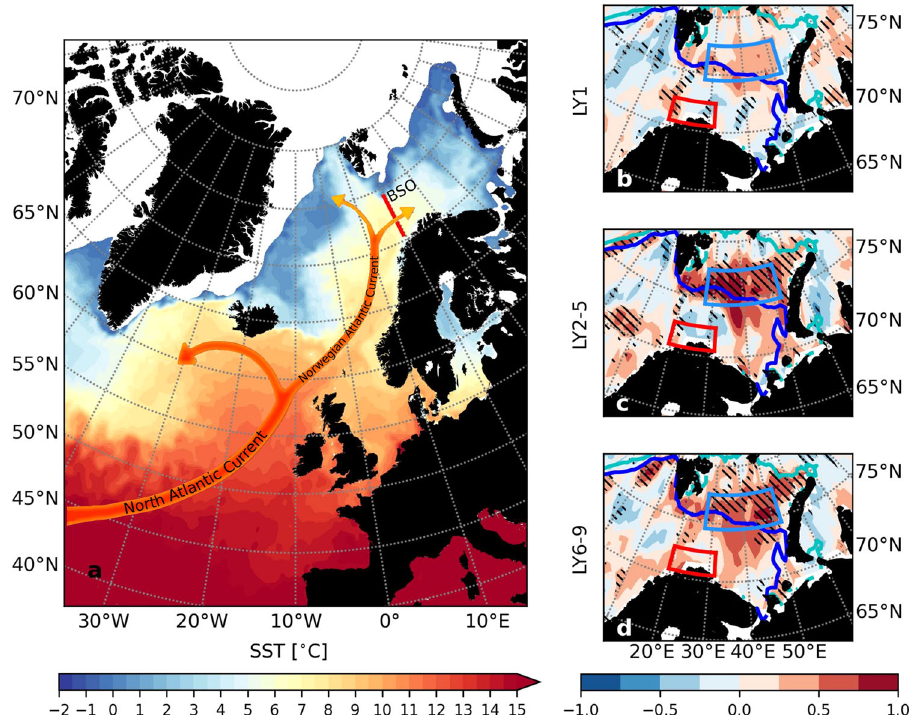
Fig. 1 Phytoplankton predictability. a Snapshot of SST in the Subpolar North Atlantic, and the Nordic and Barents seas from the OCCI dataset 67,68 , daily mean from April 15 2007. Areas with an ice cover exceeding 30% are marked in white. The pathways of the North Atlantic and Norwegian Atlantic currents are marked with arrows. The Barents Sea Opening is marked with a red line. b – d Anomaly correlation ( fi lled contours) between annual mean observed (satellite-derived) chlorophyll and dynamically predicted annual mean phytoplankton carbon concentration for the period of 1998 – 2018, for 1 year after the initialization (lead year 1) ( b ), lead years 2 – 5 ( c ), and lead years 6 – 9 ( d ). Striped regions indicate that the correlation is signi fi cantly different from zero and also signi fi cantly different from the correlation between the hindcasts and the historical simulation. The latter criterion ensures that the skill is associated with internal climate variability, and is not simply driven by external forcing (i.e., climate change). The blue and turquoise lines show the maximum (1998) and minimum (2006), respectively, summer (average over May – July) sea ice extent (30%) during the period 1998 –